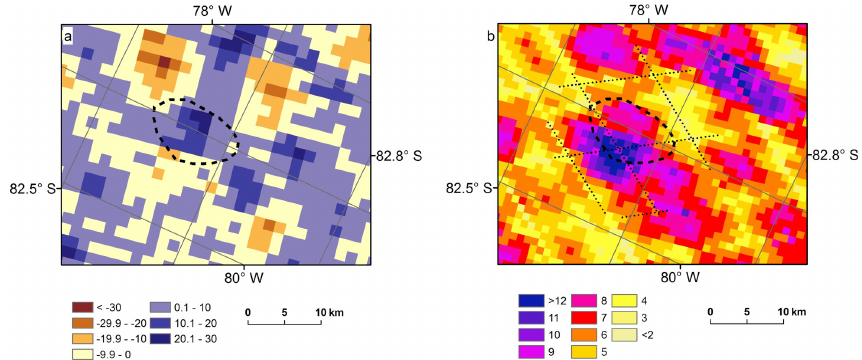
Fig. 6. Quantification (in meters) of errors in ice sheet surface elevation measurements. (a) Difference between Griggs and Bamber (2009) and this paper’s (Fig. 1b) radar-altimeter surface elevations. (b) Map of the distribution of RMSE (root mean square error) in the Bamber et al. (2009) ice surface digital elevation model (DEM) (derived in this area exclusively from ICESat data) calculated using a multiple regression based on airborne validation data (adapted from Fig. 11 of Griggs and Bamber, 2009). Also shown is the outline of Institute E2, as proposed by Smith et al. (2009) (black dashed line), and ICESat lines (in b ), which are oriented such that those closest to the 80 ◦ W longitude are also closest to the Easting’s axis in Fig. 2.